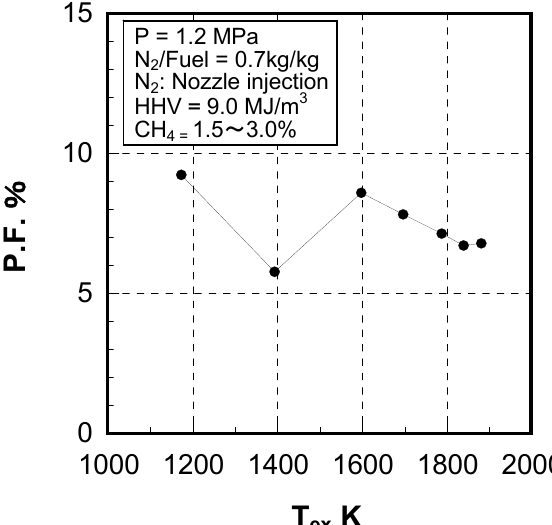
Figure 87. Temperature deviation characteristics of combustor